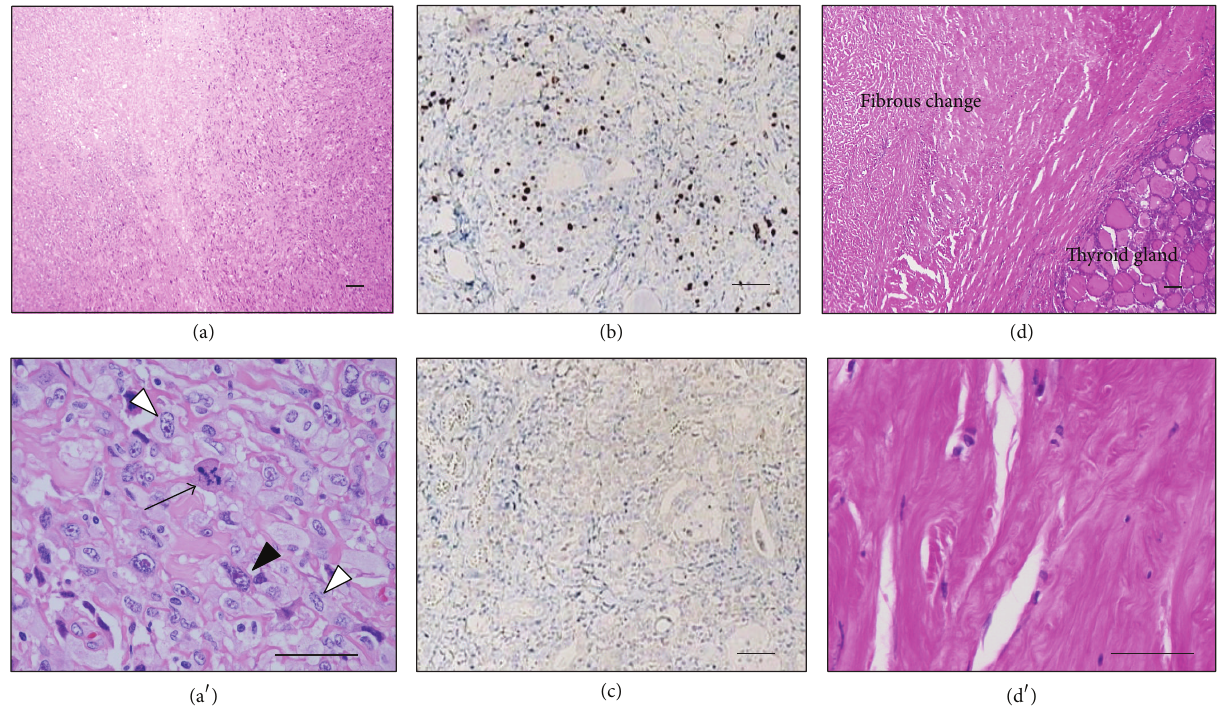
Figure 2: Pathological analysis of anaplastic thyroid cancer. (a, a 󸀠 ) Hematoxylin and eosin (HE) stained tumor section. High magnification is shown in the lower panel (a 󸀠 ). The tumor cells were composed of polygonal cells (closed arrowhead), spindle cells (open arrowheads), and multinucleated cells (arrow) with necrosis. (b) The Ki-67 labeling index was 50%. (c) The tumor cells were negative for p53. (d, d 󸀠 ) HE stained section of the thyroid gland after autopsy. It should be noted that the tumor is completely substituted by fibrotic tissue. Scale bars = 50 𝜇 m.